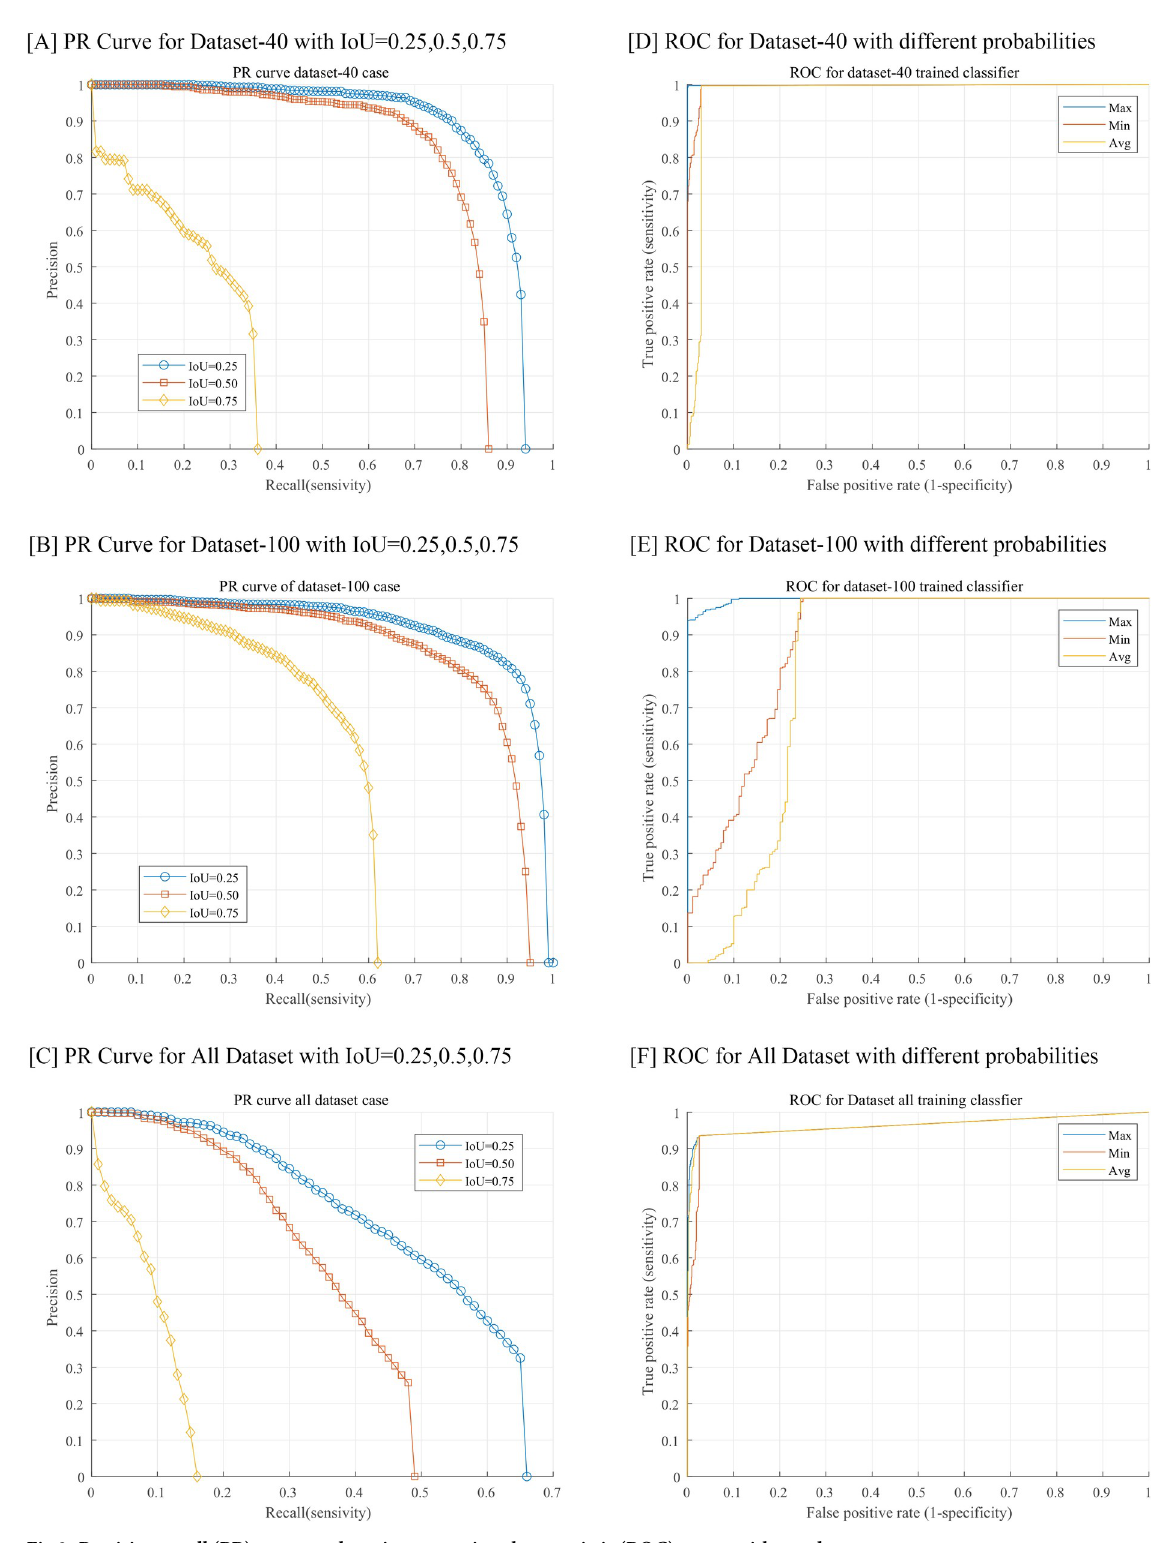
Fig 2. Precision-recall (PR) curves and receiver operating characteristic (ROC) curves with test datasets.